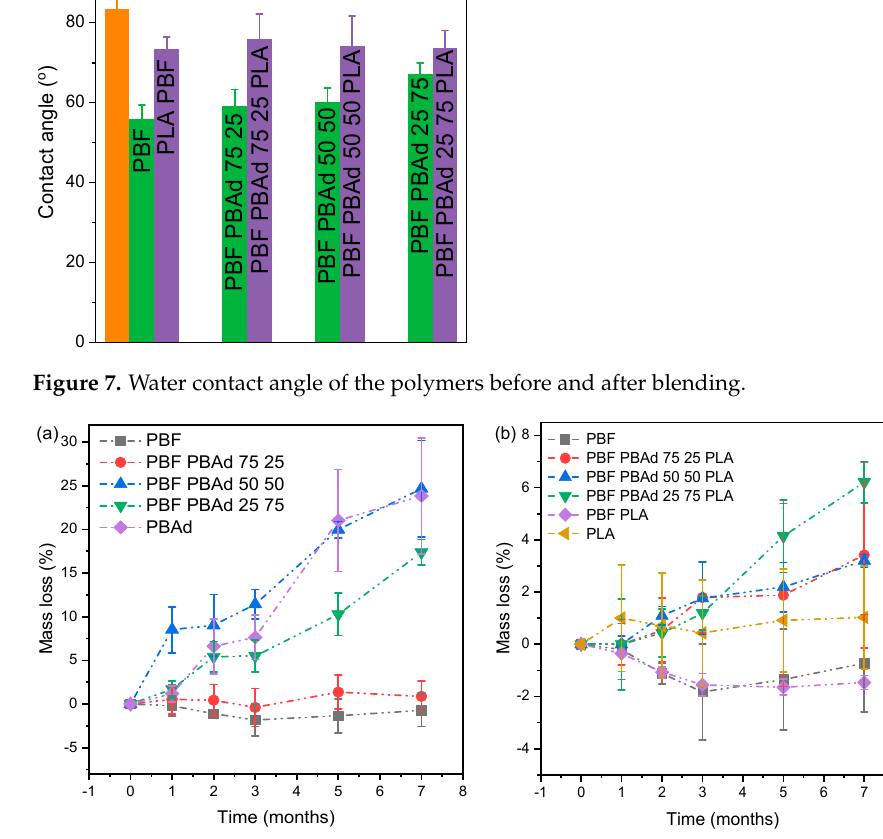
Figure 8. Cumulative mass loss of ( a ) PBF, PBAd and their copolymers, and ( b ) PBF, PLA and the blends during soil burial.